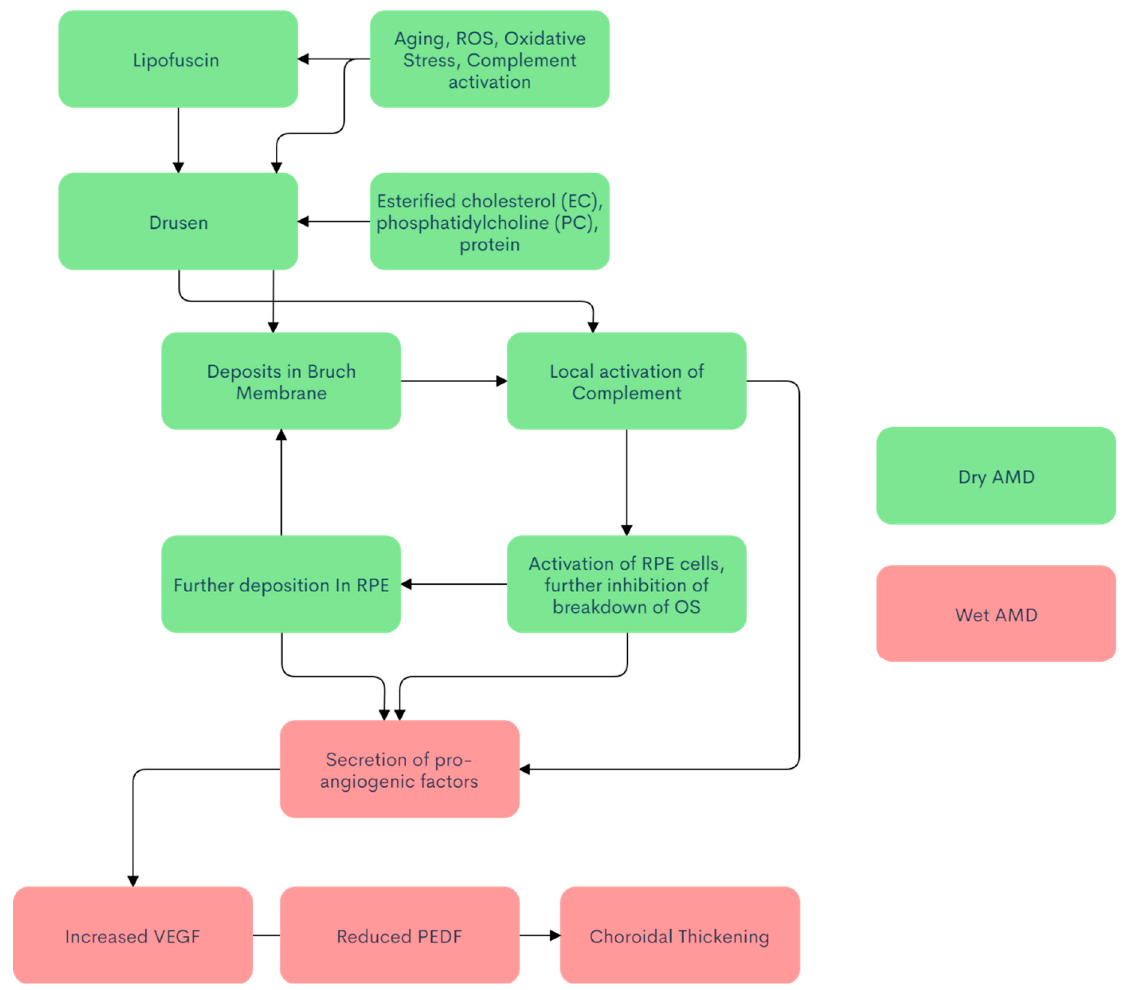
Figure 1. Flowchart of AMD pathogenesis.